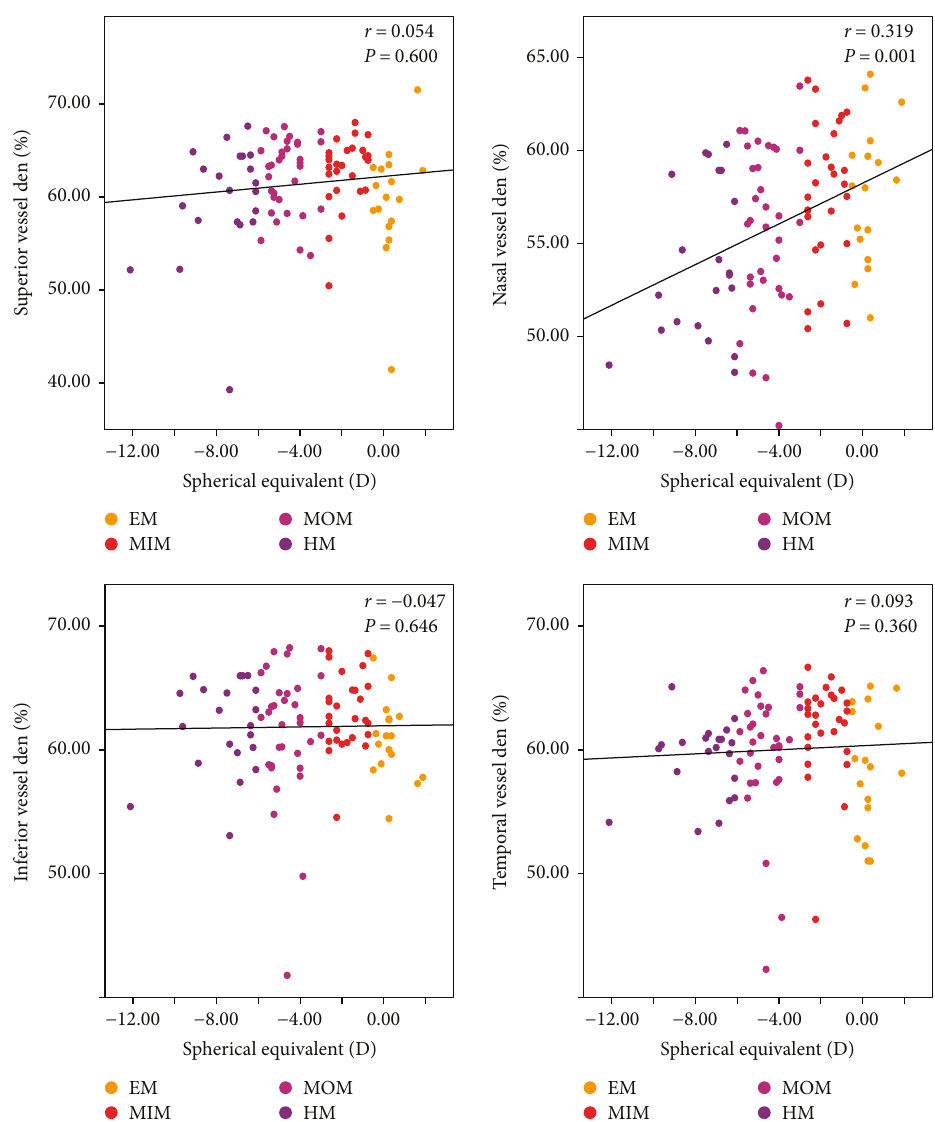
Figure 5: Scatterplots illustrating the linear (black line) associations between spherical equivalent (D) and optical coherence tomography angiography (OCTA) peripapillary quadrant (superior, nasal, inferior, and temporal) vessel density (%) measurement of the studied eyes. r , correlation coe ffi cient from the Spearman rank correlation analysis; EM, emmetropia, MSE 0.50 D to − 0.50D; MIM, mild myopia, MSE − 0.75D to − 2.75D; MOM, moderate myopia, MSE − 3.00D to − 5.75D; HM, high myopia, MSE ≤−